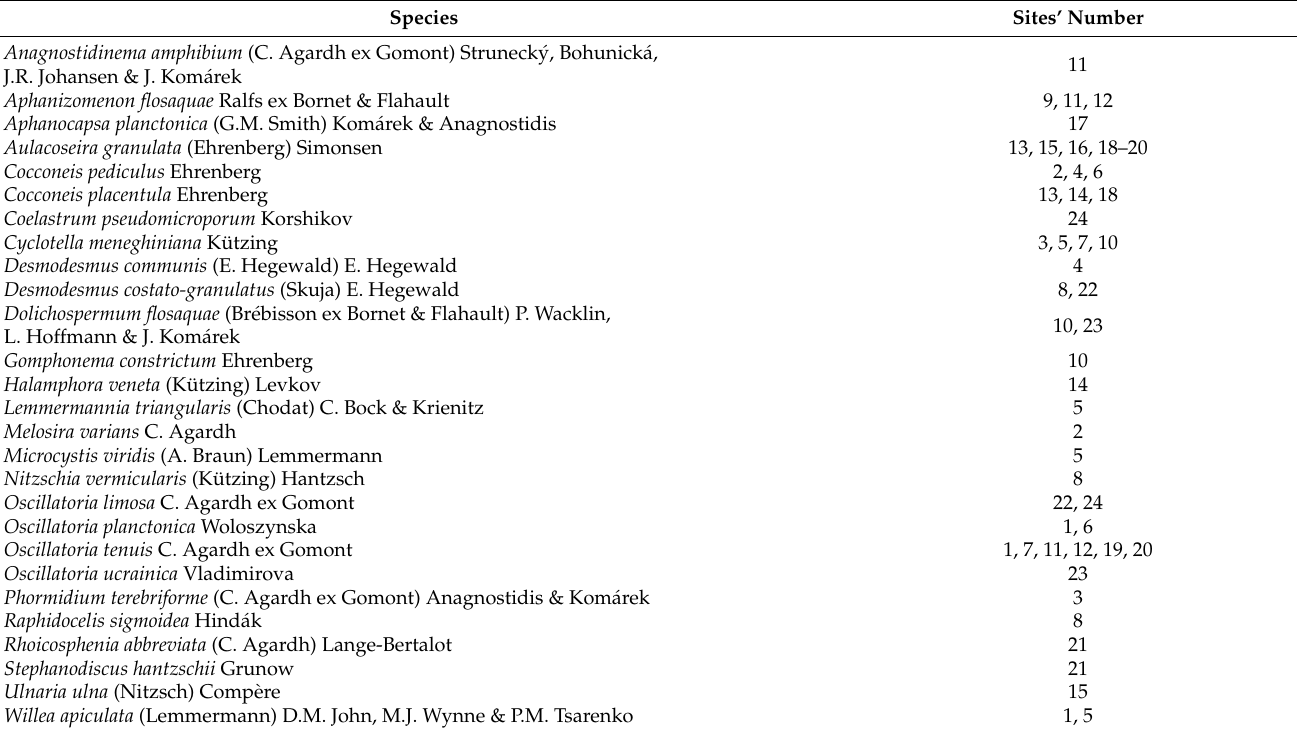
Table 4. Dominant species of algae according to abundance values in the river basin of Siversky Donets. Species